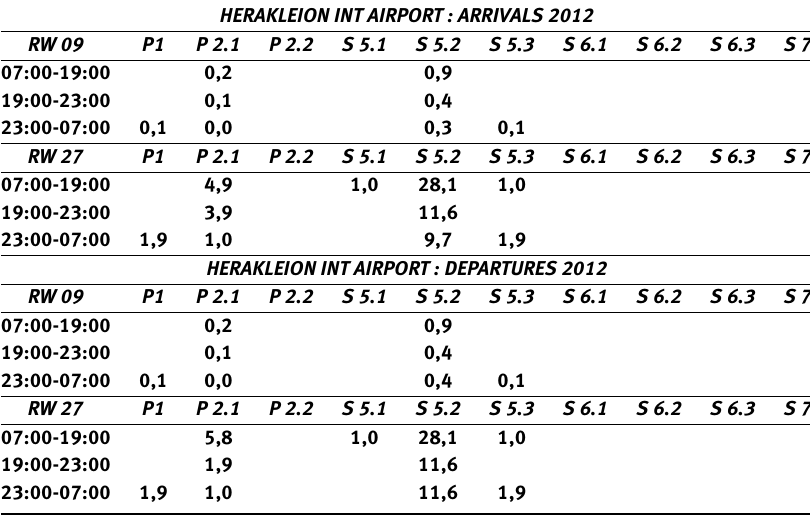
Table 1. Annual average daily aircraft movements (TOffs & landings) - 2012.